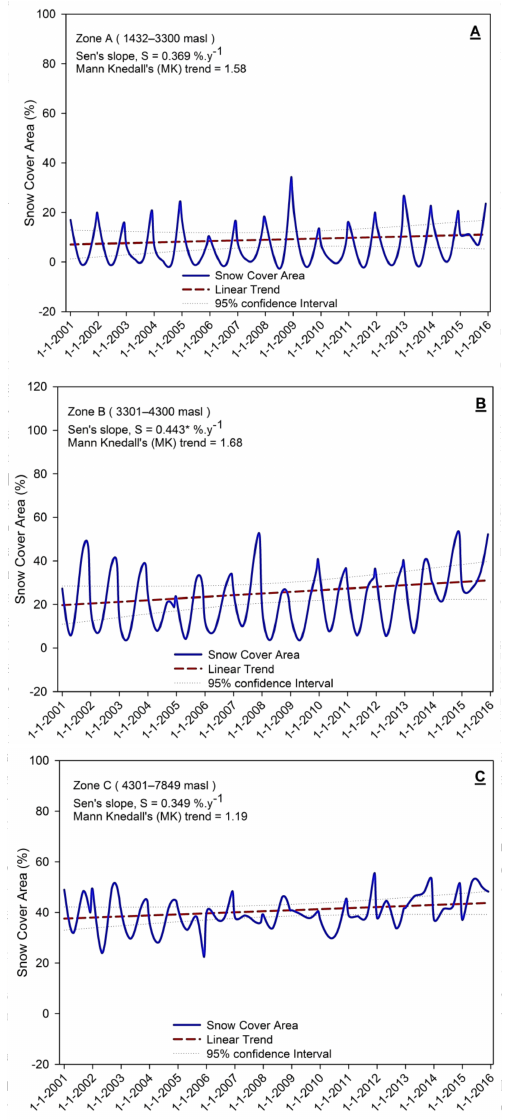
Figure 7. The trend of MODIS-data derived snow-covered area the Hunza River basin, in three altitudinal zones shown in ( A – C ), over a 15-year period